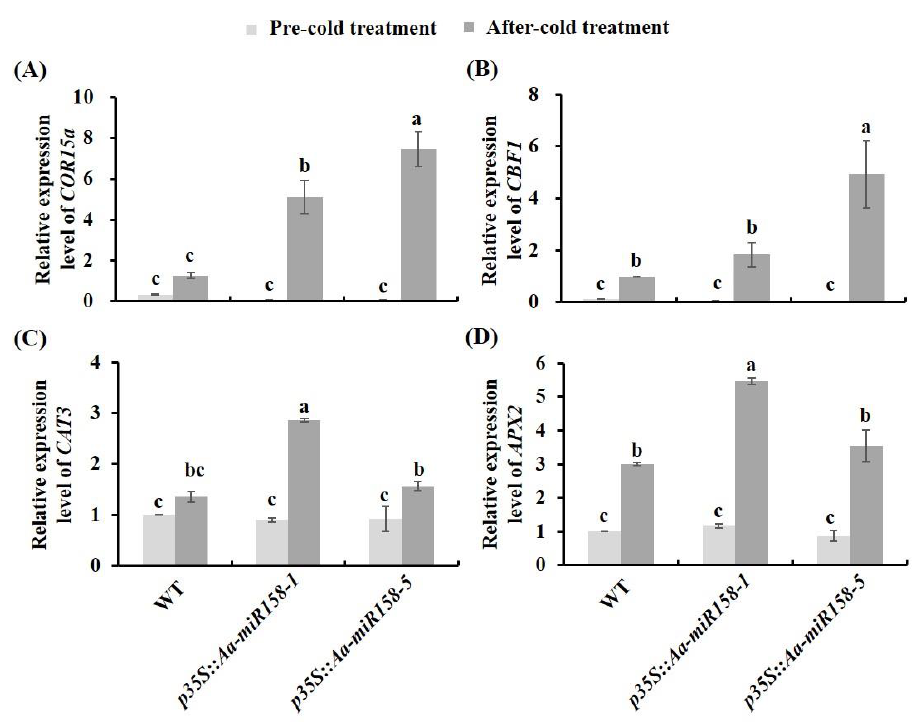
Figure 7. Relative expression levels of genes related to cold stress and ROS in leaves of pre-Aa-miR158 transgenic ( p35S::pre-Aa-miR158 -1 and p35S::pre-Aa-miR158 -5) and wild-type (WT) Arabidopsis plants under cold stress. ( A ): COR15a ; ( B ): CBF1 ; ( C ): CAT3 ; ( D ): APX2 . Error bars represent standard deviations ( n = 3). Within each graph, values marked with the different letter are significantly different ( p < 0.05, Student ’ s t -test).